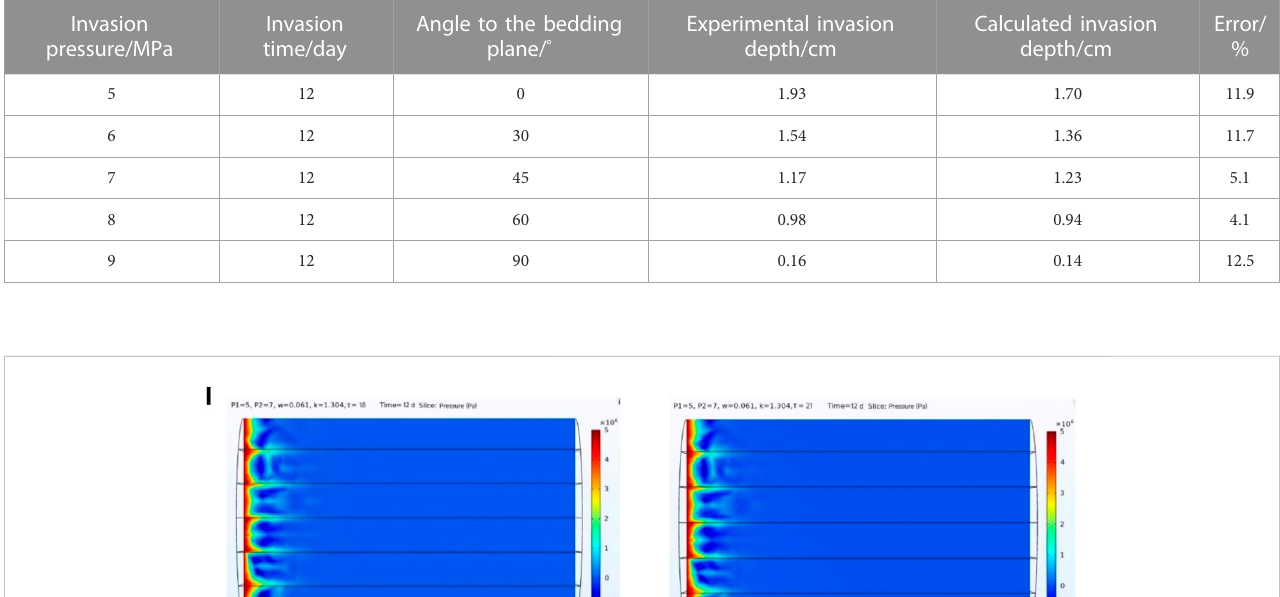
TABLE 5 Calculated and experimental values of invasion depth under different angles to the bedding plane.